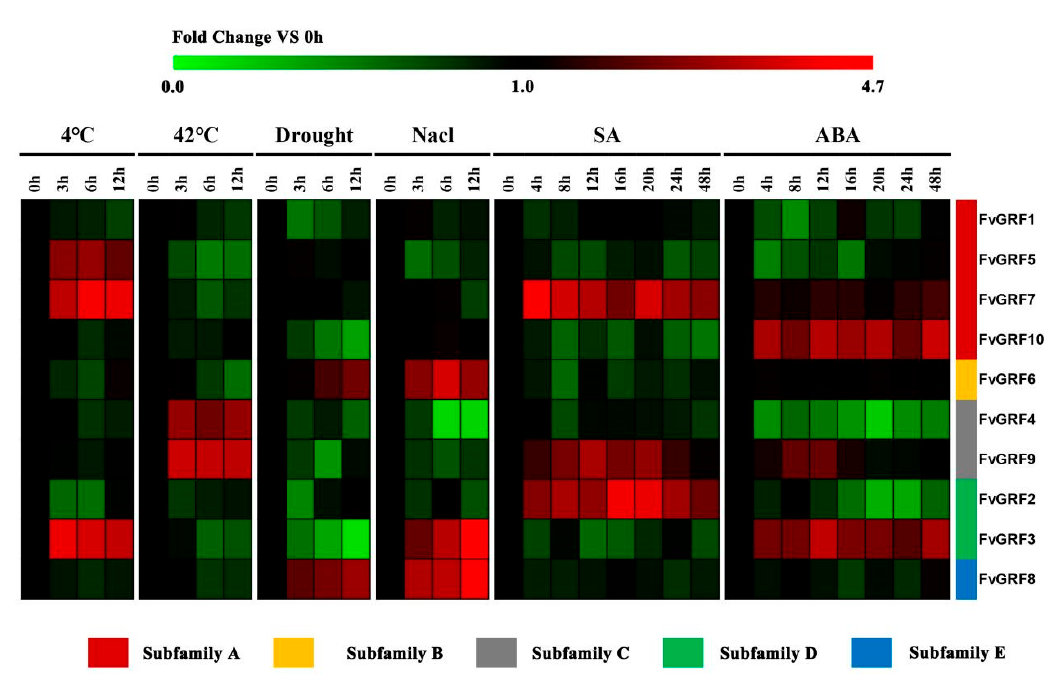
Figure 4. Expression accumulation profiles of 10 woodland strawberry GRF genes in response to low temperature (4 ◦ C), high temperature (42 ◦ C), drought, NaCl, salicylic acid (SA), and abscisic acid (ABA) treatments as determined by quantitative RT-PCR analysis and displayed in the form of heat maps. The color scale indicates the change in expression level, where red indicates an increase and green indicates a decrease, relative to that at 0 h. The experiment was repeated three times and the results were